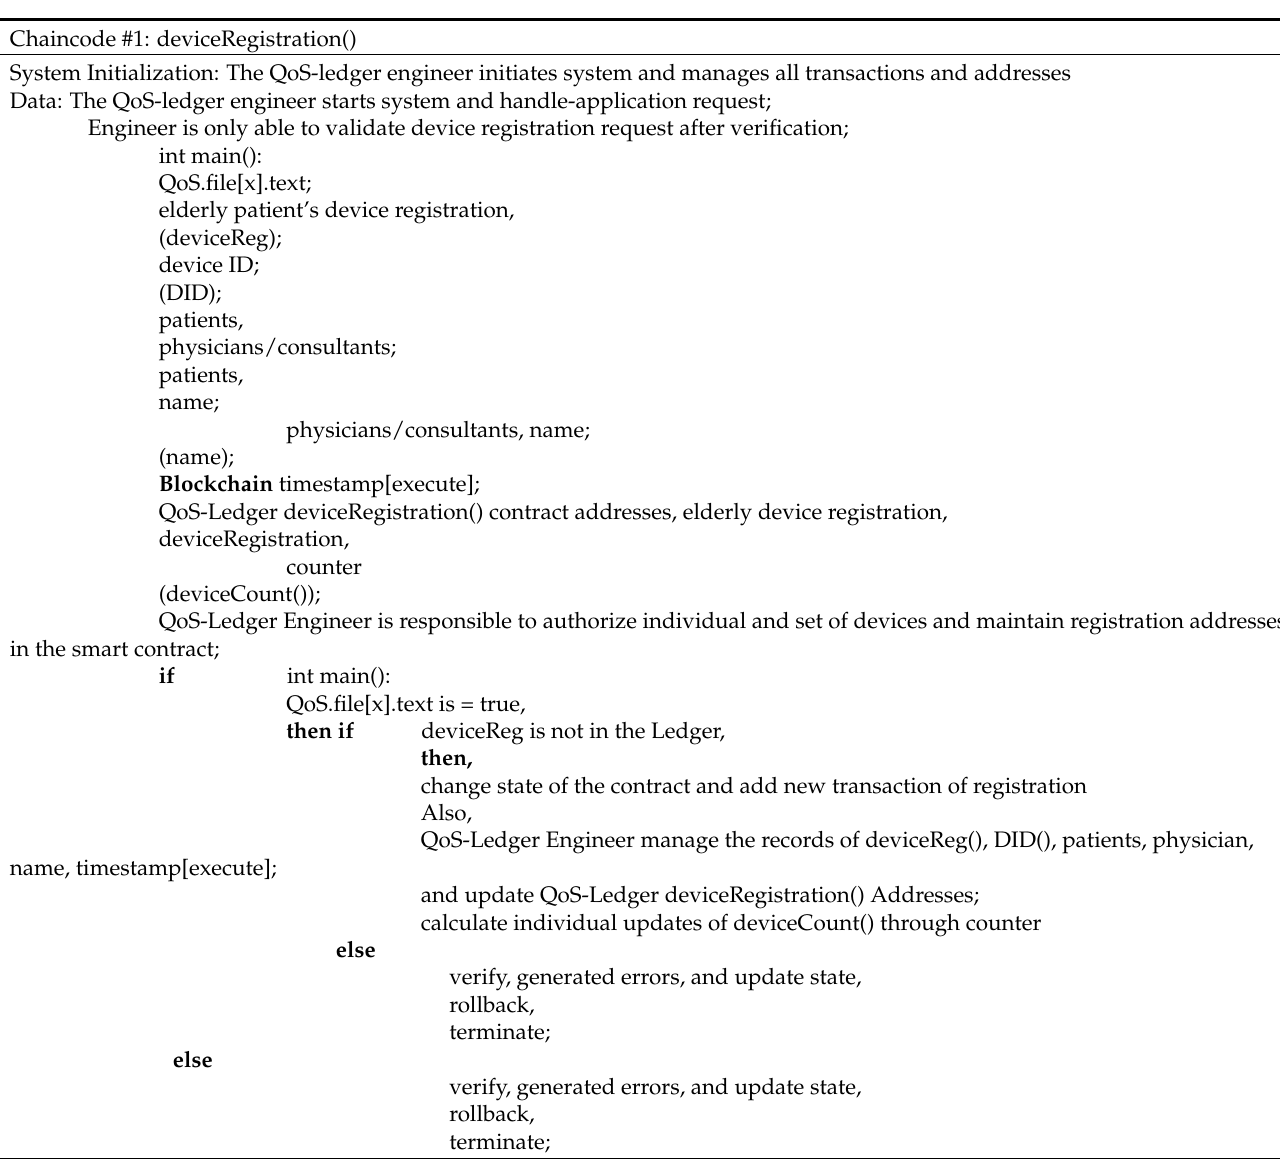
Table 2. Smart contract-1 for medical device registration with secure